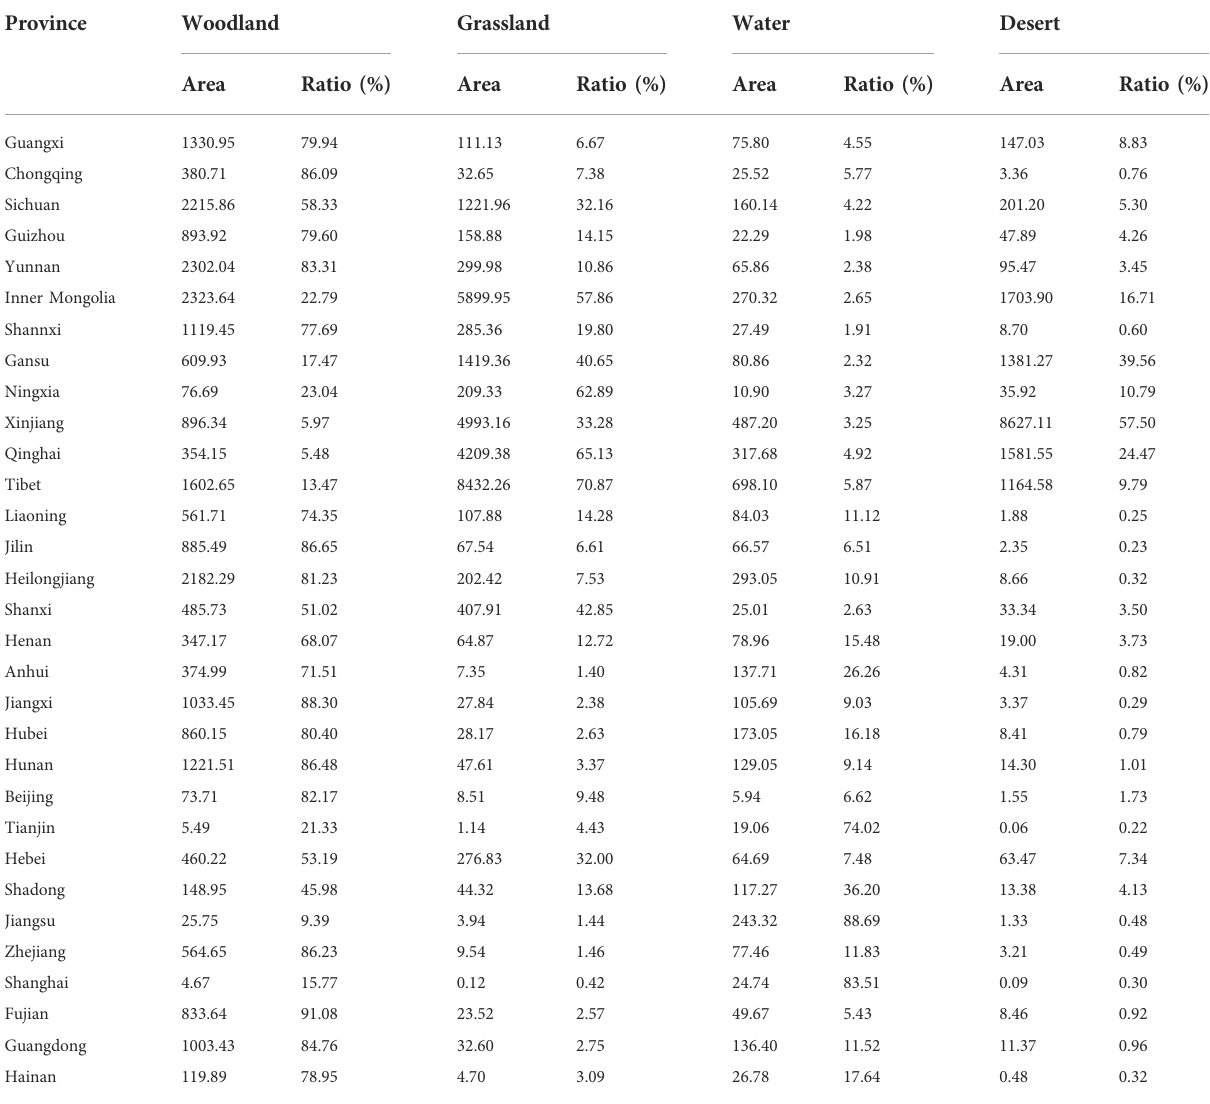
TABLE 5 Area and ratio of ecological space types in respective jurisdictions in